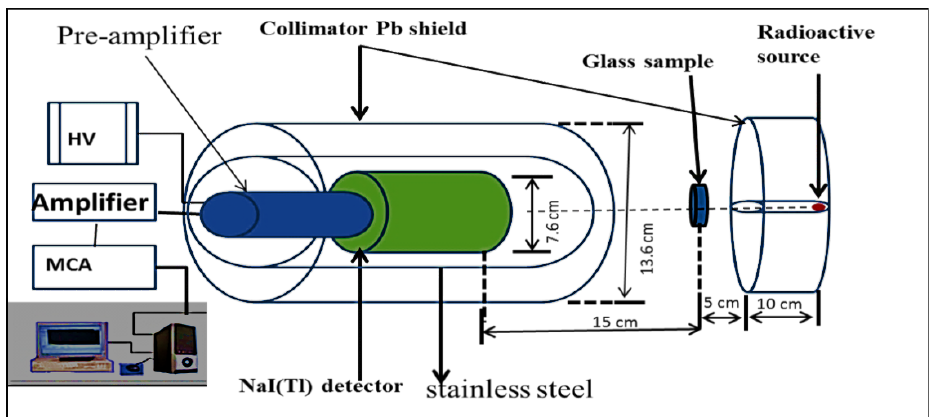
Figure 2. Experimental setup for gamma ray measurement.